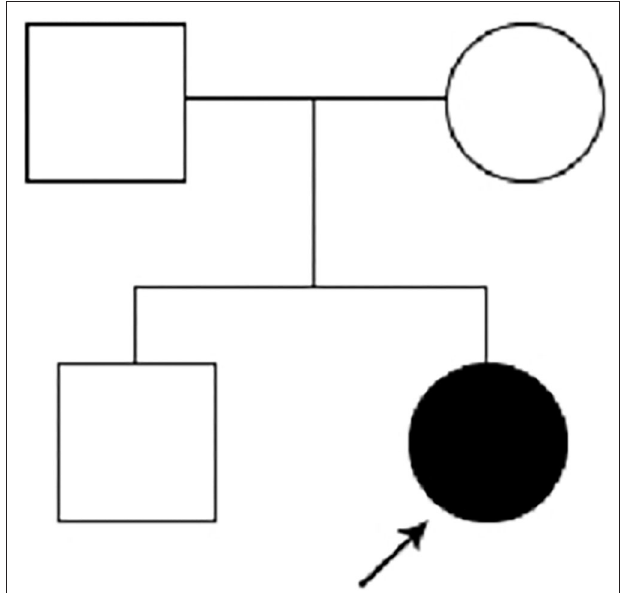
FIGURE 3 | Pedigree of the